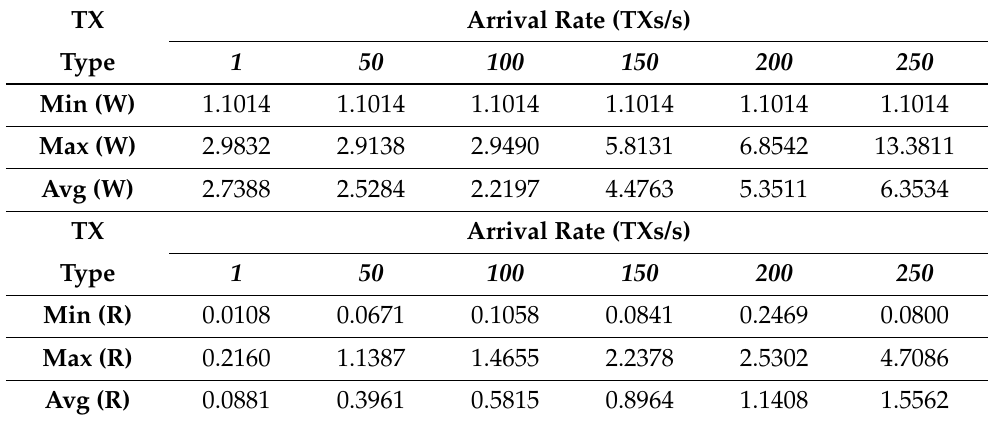
Table 1. Latency measures, in seconds, for read (R) and write (W) TXs where network size = 4.